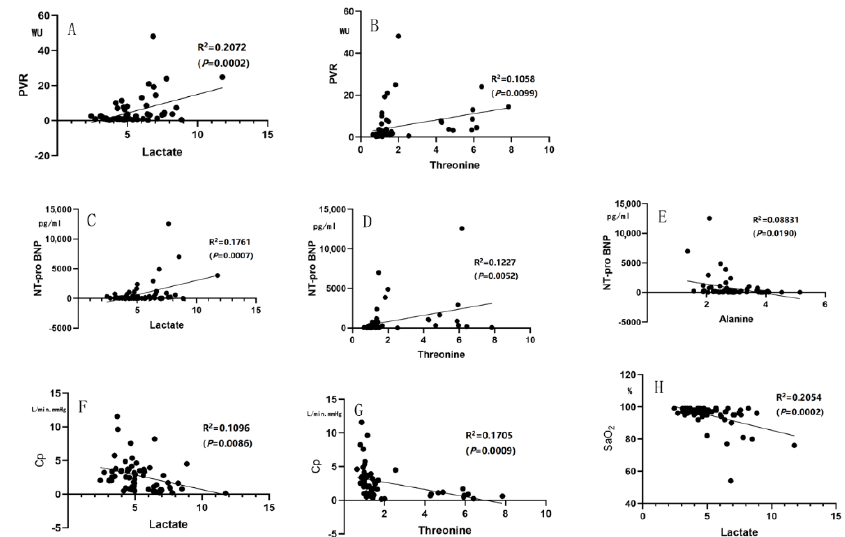
Figure 7. Correlation analysis. ( A , B ) Lactate and threonine were positively correlated with PVR; ( C – E ) Lactate and threonine were positively correlated with NT − proBNP, while alanine was negatively correlated with NT − proBNP; ( F , G ) Lactate and threonine were negatively correlated with Cp; ( H ) Lactate was negatively correlated with SaO 2 .